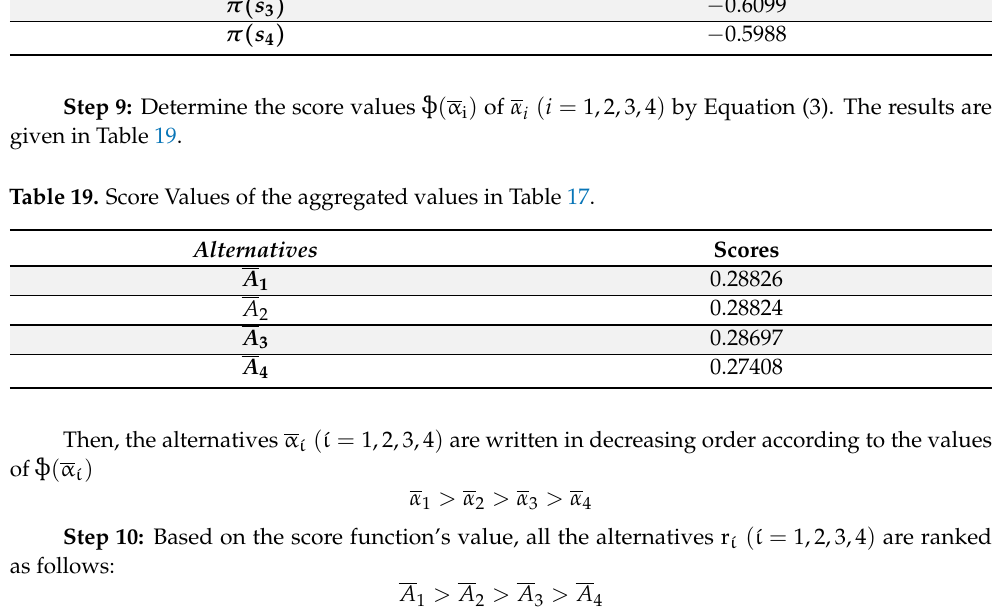
Table 19. Score Values of the aggregated values in Table 17.